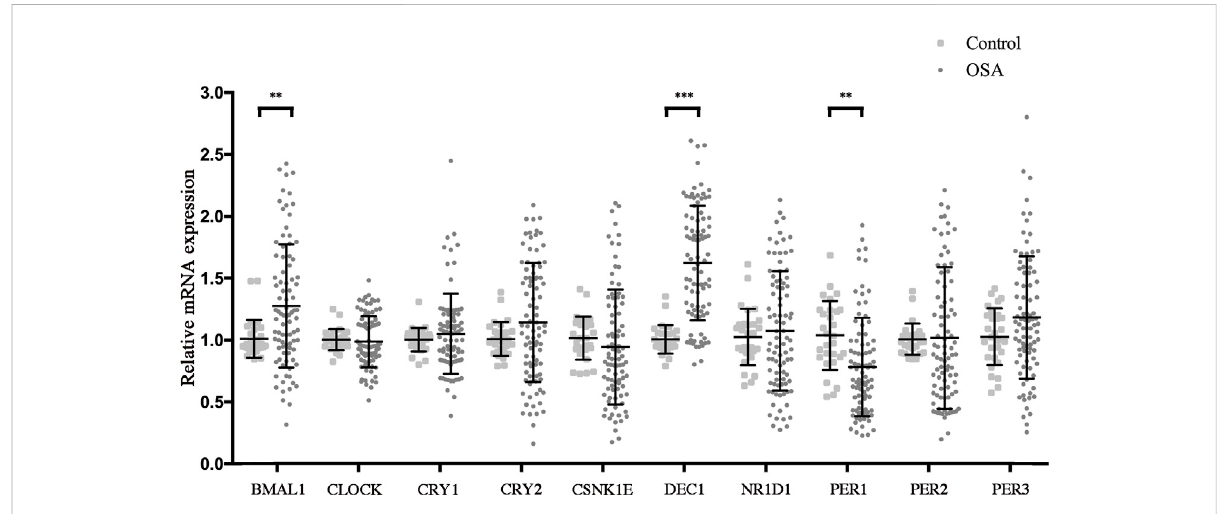
FIGURE 2 OSA dysregulated the circadian clocks. Relative mRNA expressions of circadian clock genes in the peripheral blood mononuclear cells from control and OSApatients. Mean values from thecontrol groupweresetat1.0. Experimentswererepeated threeindependenttimes.**, p < 0.01; ***, p <